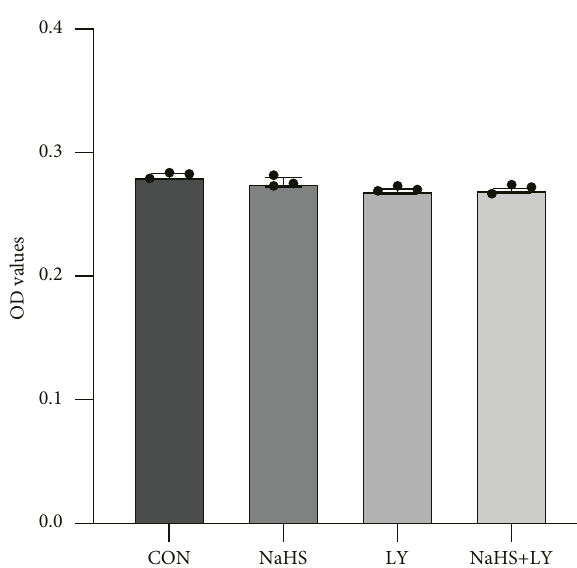
Figure 5: Impact of NaHS and LY294002 on HUVECs growth. No statistical signifcances were observed among groups. CON: control groups, HUVECs without any treatment. NaHS: HUVECs exposed to 200 μ mol/L NaHS. LY: HUVECs exposed to 10 μ mol/L LY294002. NaHS +LY: HUVECs exposed to 200 μ mol/L NaHS and 10 μ mol/L LY294002